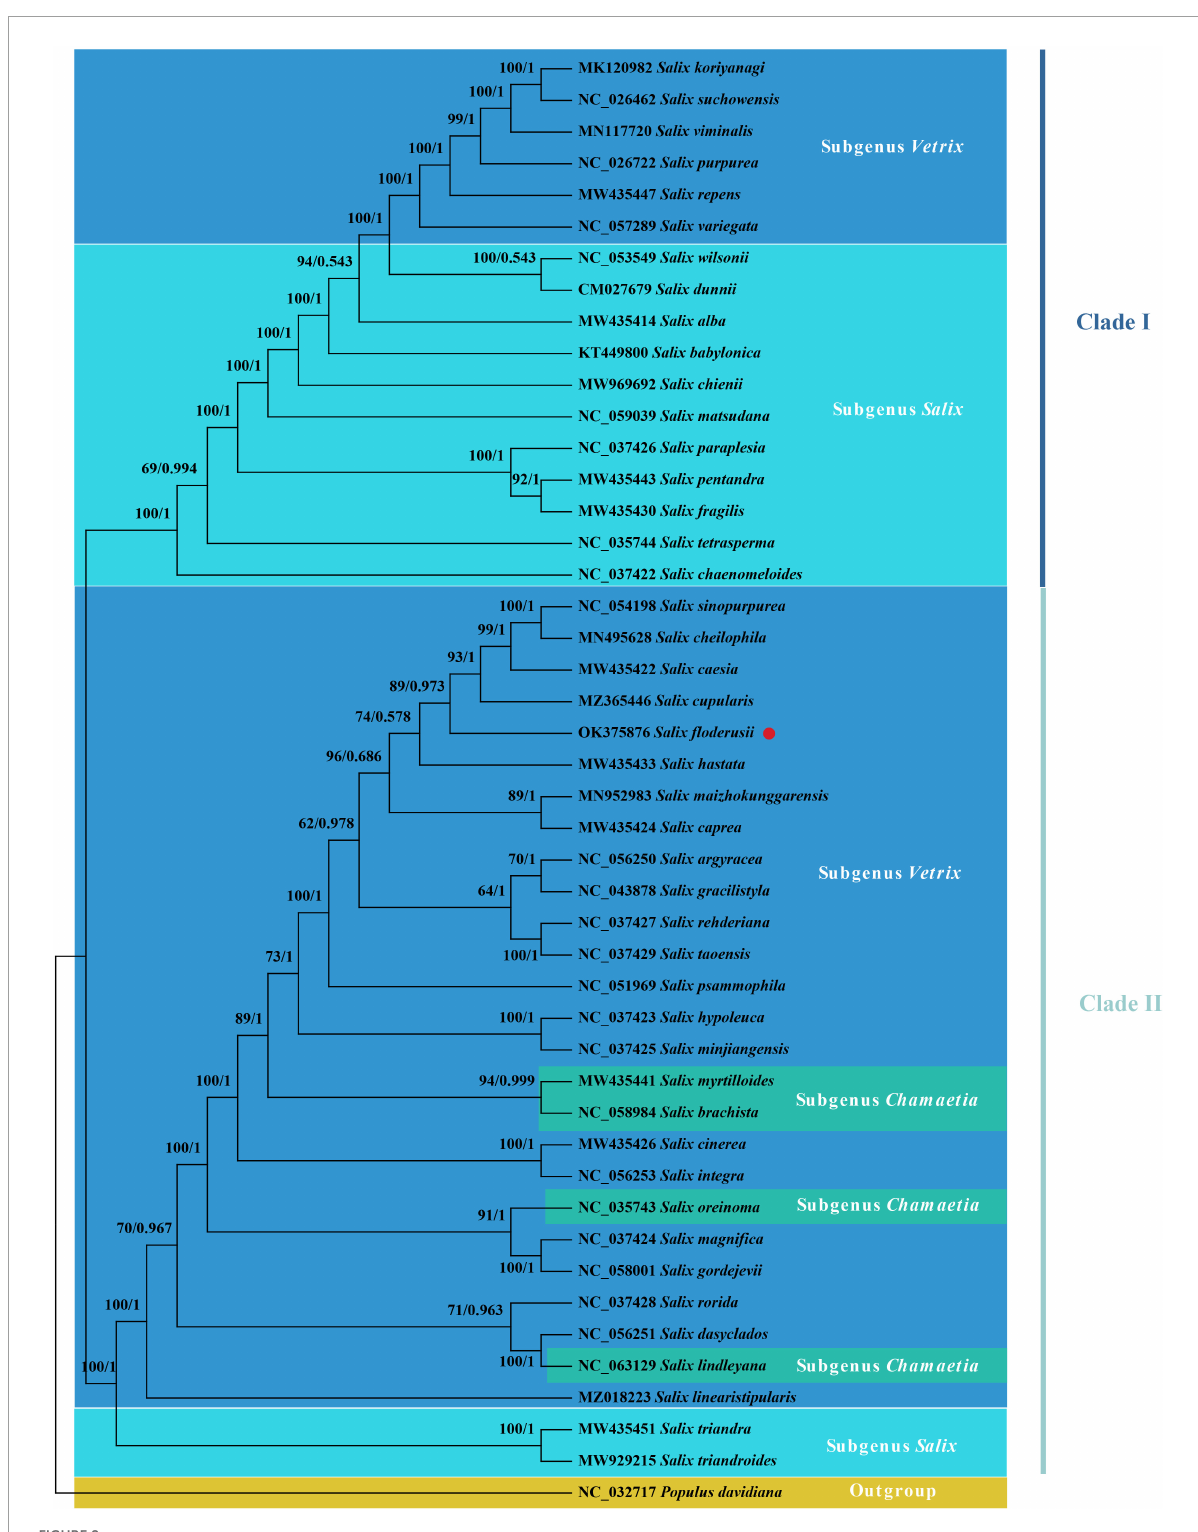
FIGURE8 Phylogenetic analysis. The phylogenetic tree inferred from maximum likelihood (ML) and Bayesian inference (BI) of 46 cp genomes from 45 species from the Salix genus and Populus davidiana as an outgroup. The numbers above the branches are the posterior probability and likelihood values, respectively. The species studied in the present study was marked using red